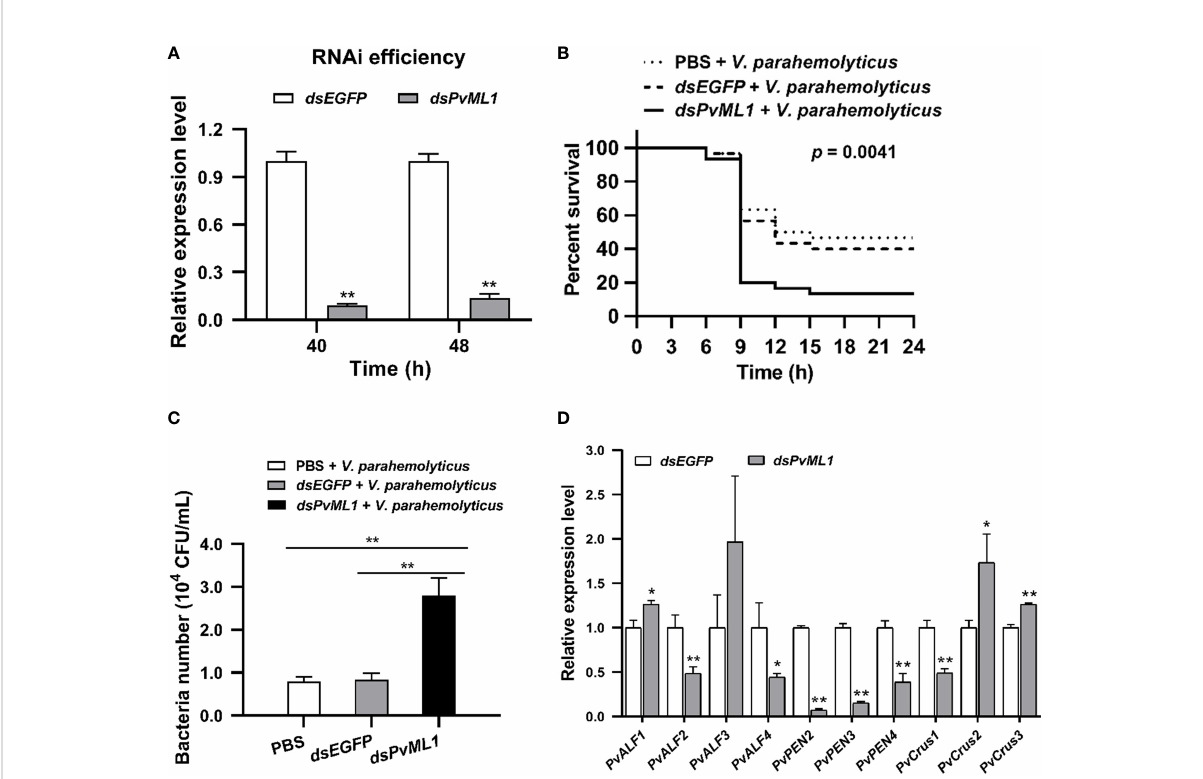
FIGURE 5 The effects by PvML1 knockdown on survival rate, bacterial clearance, and AMP expression in hemolymph. (A) Effective knockdown for PvML1 in hemocytes by dsRNA was con fi rmed by qRT-PCR. (B) Survival of V. parahemolyticus challenged PvML1 -silenced shrimp and EGFP dsRNA treated shrimp. PBS was used as control. Thirty shrimp were used for each group, and the results were analyzed by Log-rank (Mantel-Cox) test. (C) Bacteria clearance experiment upon RNA interference with dsEGFP or dsPvML1 . PBS was used as control. (D) qRT-PCR analysis of the downstream antimicrobial peptide genes. The results presented the mean of three individual experiments. Asterisks indicate the signi fi cant differences compared with values of the control (* P < 0.05; ** P <